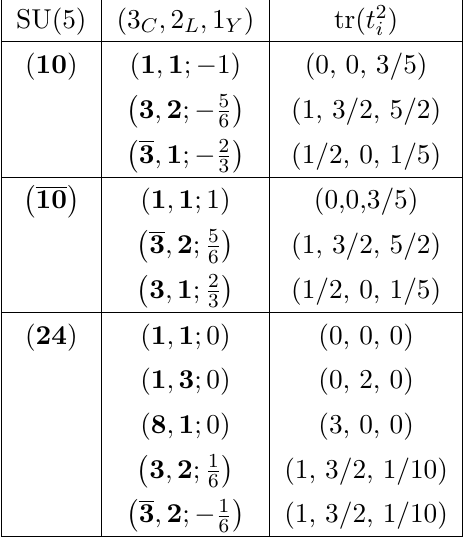
Table 5 . Decomposition of the real 45 representation under SU(5) and one-loop coe(cid:14)cients. For the sake of convenience, the would-be goldstone modes of all super-heavy gauge bosons have been provided from the scalar representation 45 H